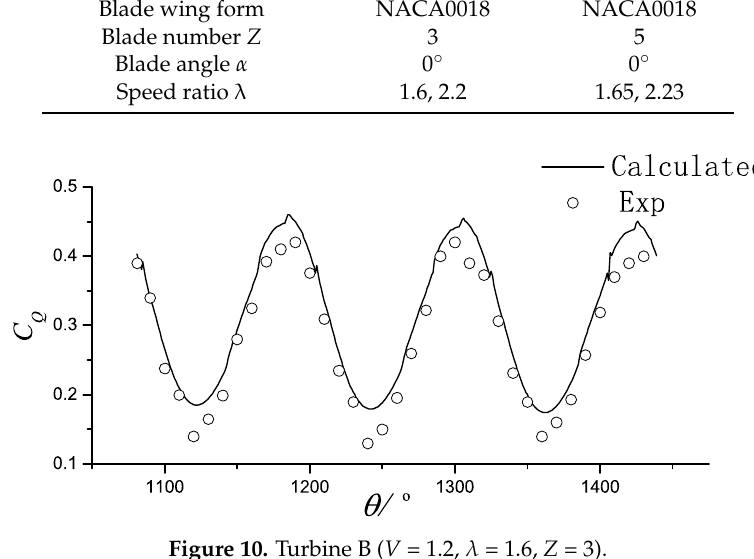
Figure 10. Turbine B ( V = 1.2, λ = 1.6, Z = 3).